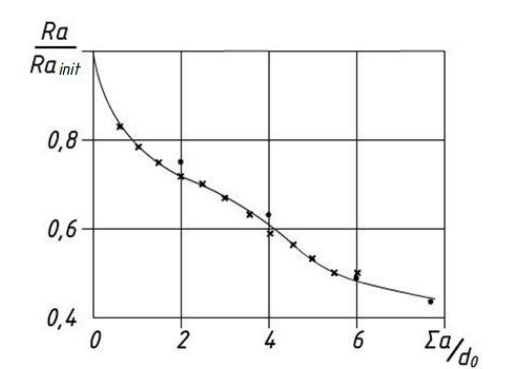
Fig. 5. The dependence of the parameter R a /R a init when processing bushings:  – from titanium VT1-0: